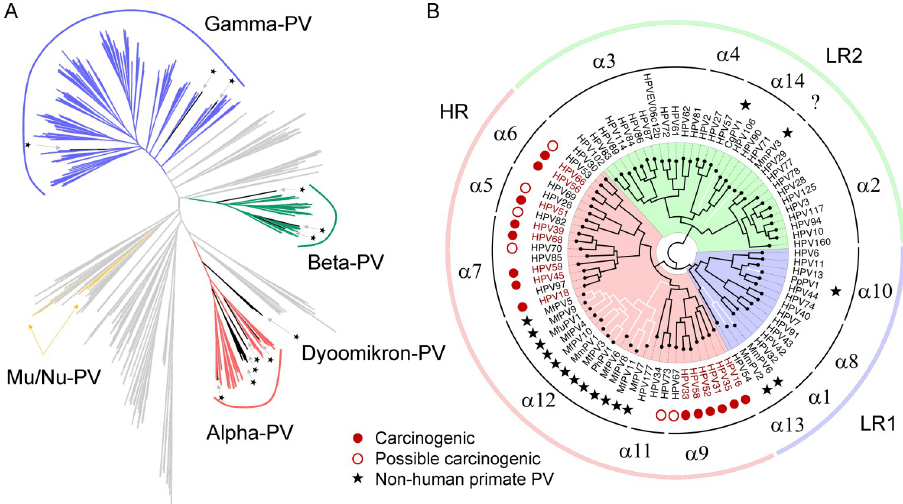
Fig 1. Phylogeny of papillomaviruses. (A) Maximum likelihood tree inferred from concatenated nucleotide sequences of four open reading frames (ORFs) (E1, E2, L2, and L1) of 640 papillomavirus genomes including 442 HPVs, 27 non-human primate PVs (NHP-PVs) and 171 non-primate animal PVs (NPA-PVs). All characterized primate PVs (HPVs and NHP-PVs) clustered into Alpha-, Beta-, Gamma-, Mu-, Nu-, and Dyoomikron-PV genera. Asterisks indicate branches/clades of non-human primate PVs. NPA-PVs are represented by gray lines. Accession numbers of the PV genomes were listed in S1 Table. (B) Maximum likelihood tree of the Alpha-PV genus inferred from concatenated nucleotide sequences of six ORFs (E6, E7, E1, E2, L2, and L1) of 66 HPV types and 17 NHP-PV types. At least three ancestral PVs are responsible for the current heterogeneous groups of genital PVs including high- risk (HR, α 5/6/7/9/11/12), low-risk 1 (LR1, α 1/8/10/13) and LR2 ( α 2/3/4/14). NHP-PV genomes are joined by white lines. Carcinogenic and possibly carcinogenic HPV types defined by the International Agency for Research on Cancer (IARC) are indicated by red dots and open circles, respectively. NHP-PV types are indicated by asterisks. Question mark indicates unknown classification.